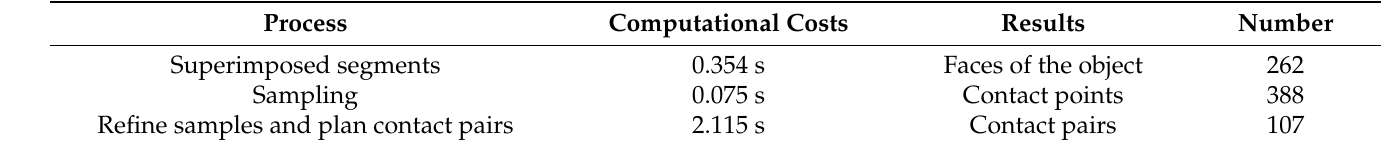
Table 1. Performance of superimposed